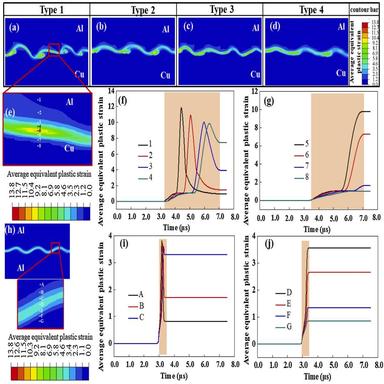
(a), (b), (c) and (d) represent the simulation results of the average equivalent plastic strain distribution at the wavy interface for the wave Type 1, 2, 3 and 4, respectively; (e) A magnified average equivalent plastic strain map of the area marked by red rectangle in wave Type 1 in.(a); changes of average equivalent plastic strain over time at points on the (f) flyer side and (g) rod side near the interface marked in (e); (h) average equivalent plastic strain map obtained from Al/Al interface with the sa